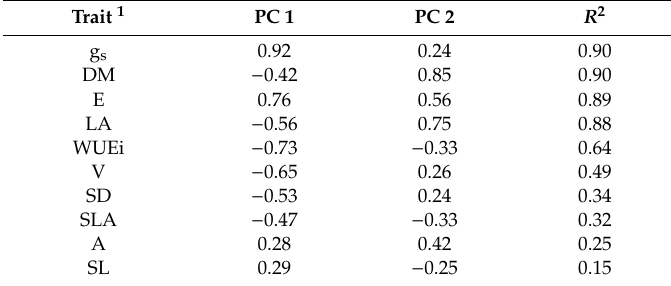
Table 3. Pearson correlation coe ffi cients between traits and the first two principal components (PC 1, PC 2); their coe ffi cients of determination ( R 2